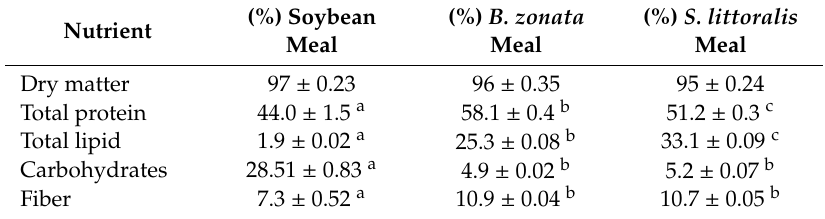
Table 2. Average nutrient compositions of soybean, B. zonata and S. littoralis meals in % (based on dry matter). (%) Soybean (%) B. zonata (%) S. littoralis Nutrient Meal Meal